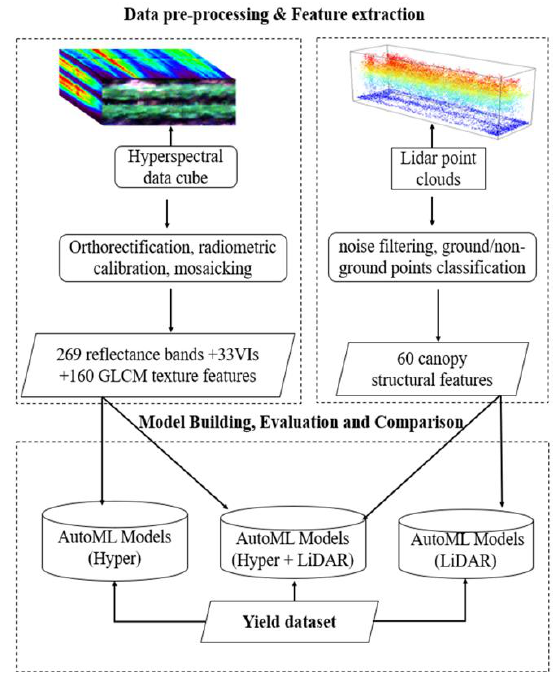
Figure 3. Workflow of hyperspectral & LiDAR data processing, feature extraction, and implementation of automated machine learning